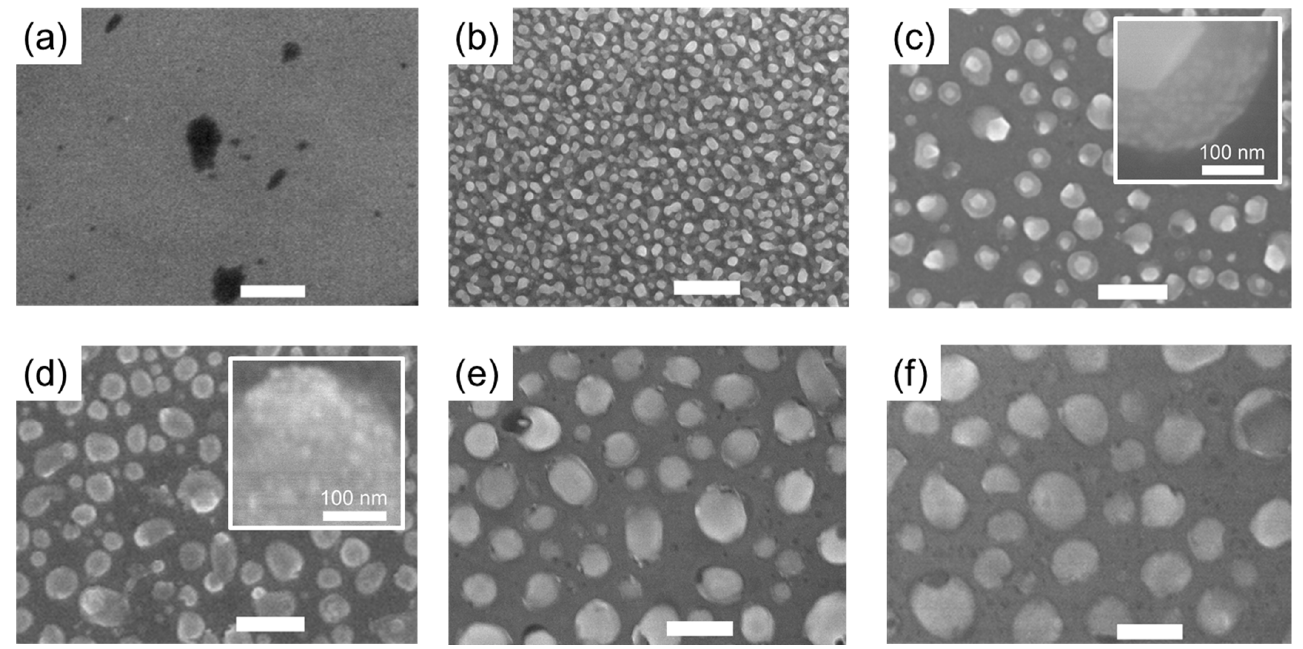
Figure 2. FESEM micrographs of annealed Ag nanofilms on the MoS 2 layers at various temperatures. The thickness of the deposited Ag film was 20 nm. Samples were annealed at ( a ) room temperature (without annealing), ( b ) 200 °C, ( c ) 400 °C, ( d ) 450 °C, ( e ) 500 °C, and ( f ) 550 °C. The solid white bars represent the 1 μ m length scale and the sold white bars in the inset of the ( c , d ) represent the 100 nm.